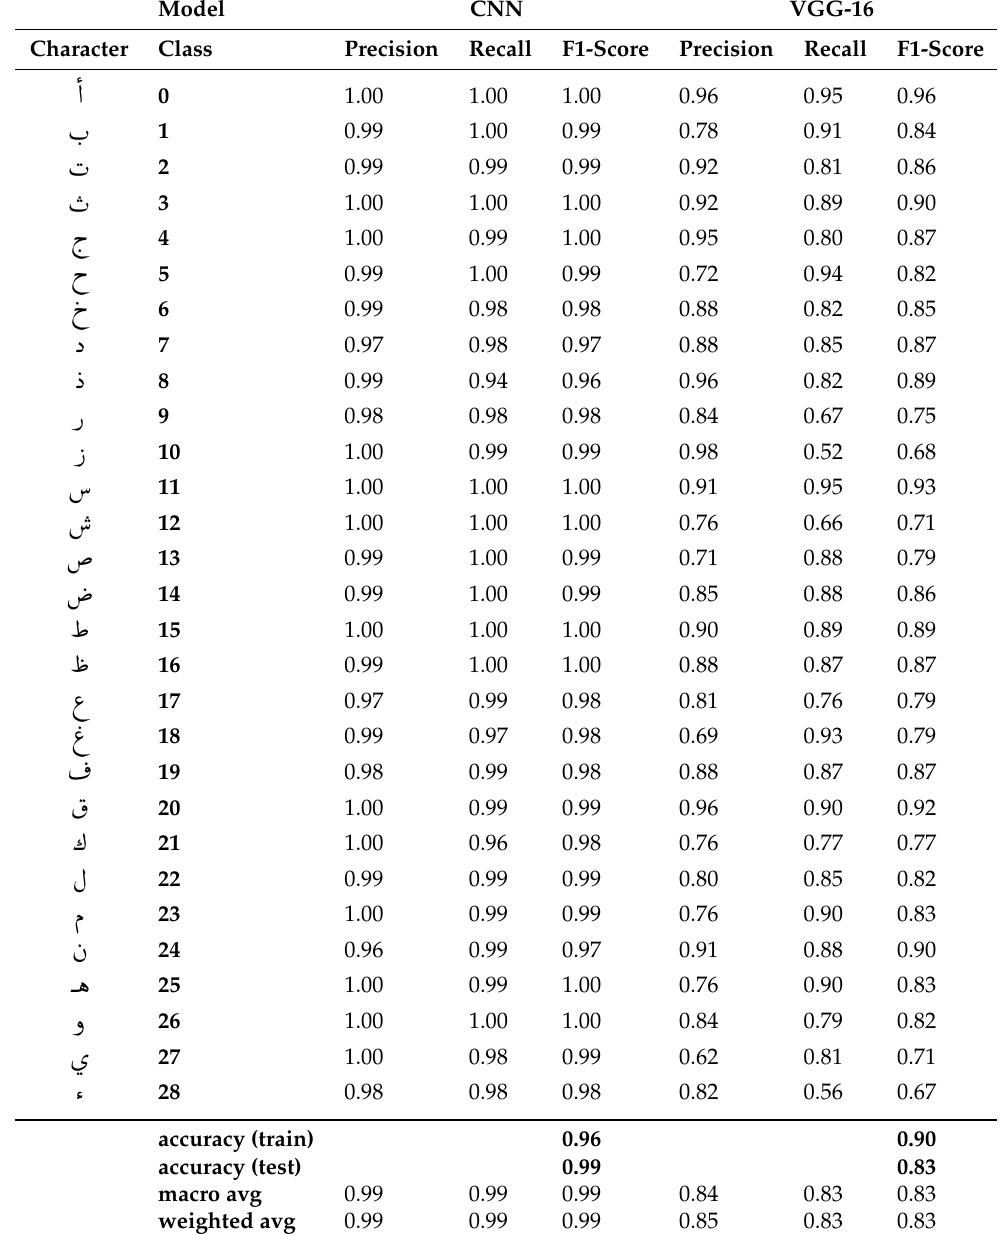
Table 3. The results and comparison of the CNN and VGG16 models for the 29 classes of the Hijja